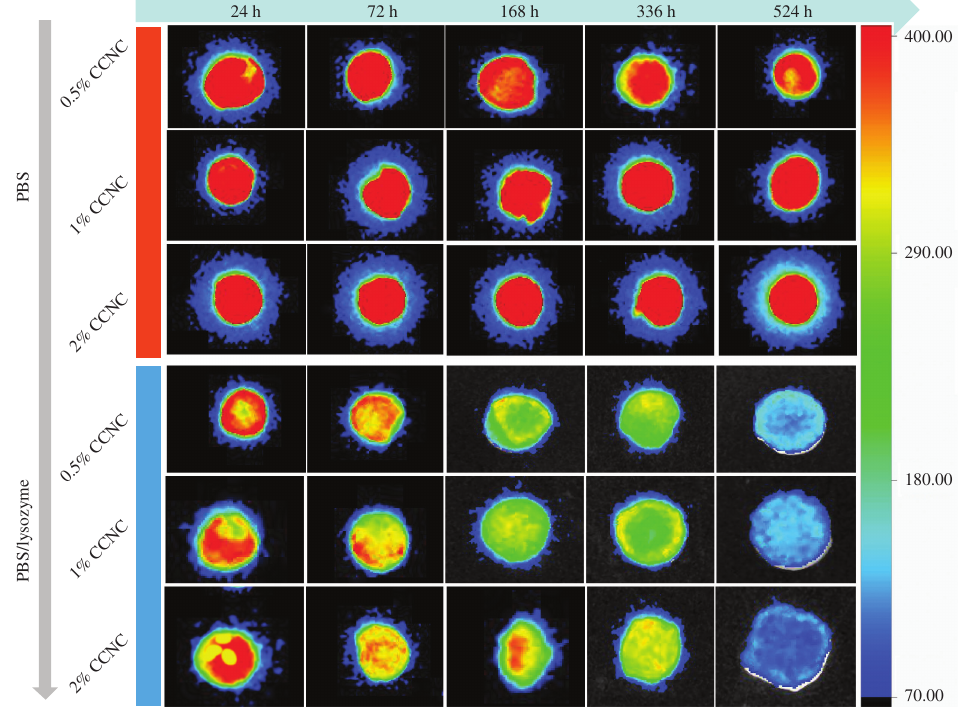
Figure 6: Representative fluorescent image of in vitro degradation of DEX/CCNC/MPDA-TPE hydrogels with different content of CCNC in the absence of lysozyme or in the presence of lysozyme over